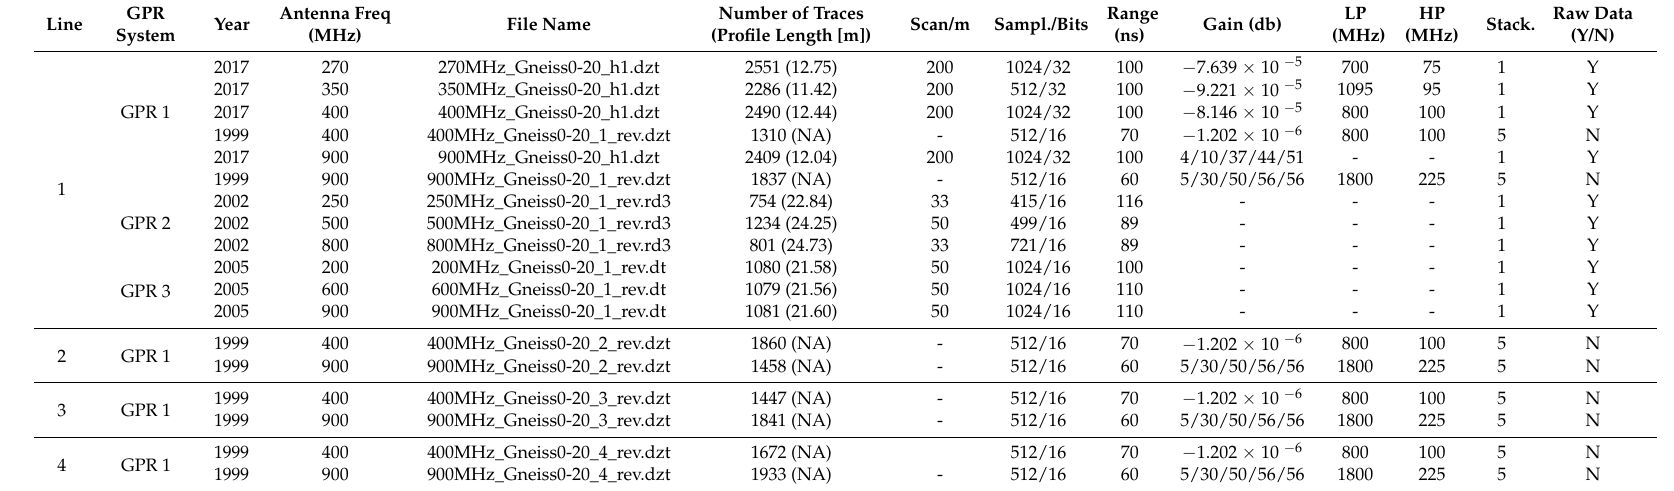
Table 7. Information about data collected in the Gneiss 0/20 gravel region. NA means not